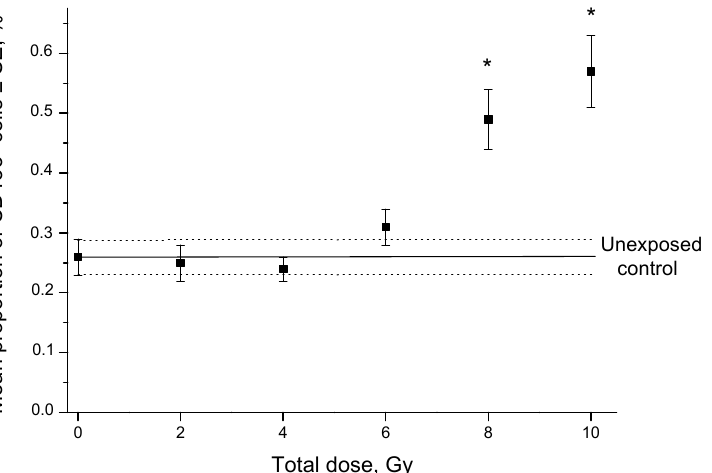
Figure 3. Effects of fractionated γ -radiation exposure on the proportion of CD133 + cells in SiHa line cultures 24 h after irradiation. The solid horizontal line indicates the mean proportion of CD133 + cells in unexposed samples with standard error (SE, dotted lines). * p < 0.05 in comparison to unexposed cells.